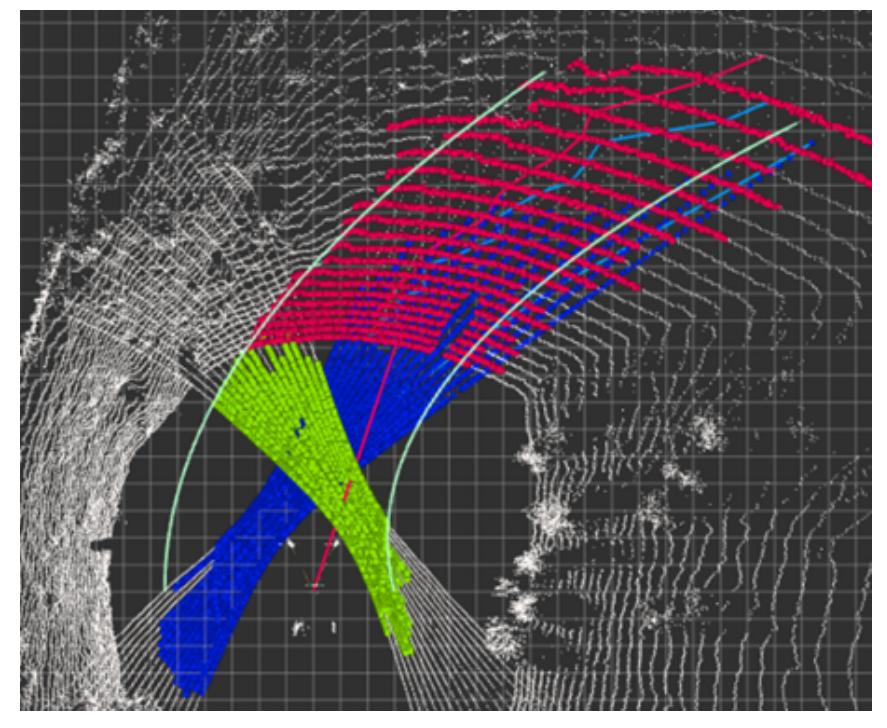
( c ) LiDAR road detection—hard curve. Figure 11. Road